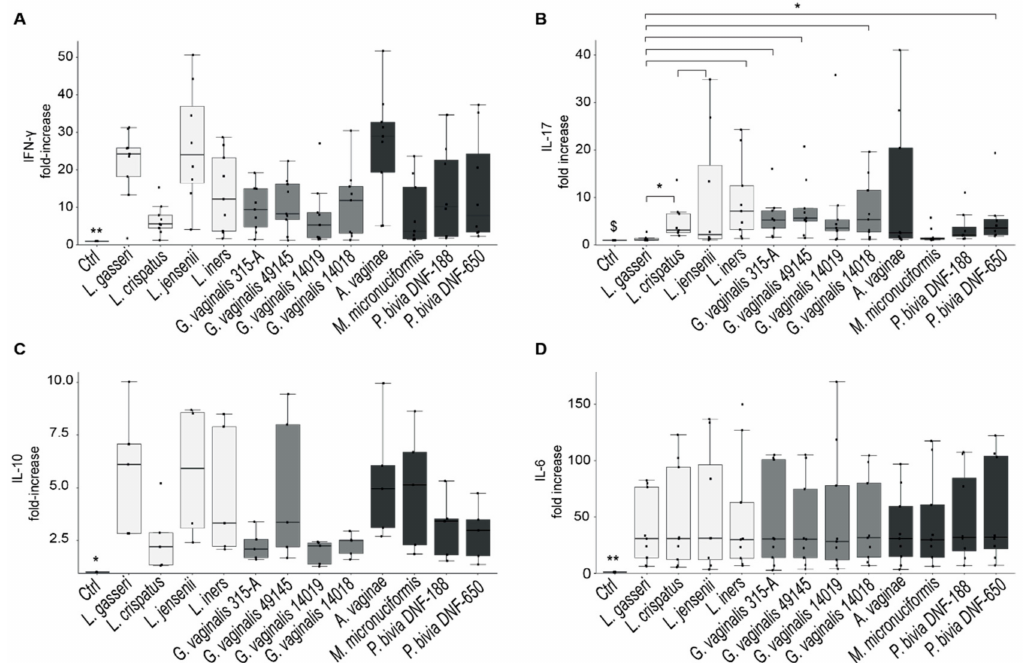
Figure 3. Cytokine’s production by PBMCs stimulated with dominant species of the vaginal microbiota. PBMCs were stimulated with 50 MOI/cell of heat-inactivated bacteria for 5 days. ( A ) IFN- γ , ( B ) IL-17, ( C ) IL-10 and ( D ) IL-6 concentration was measured in culture supernatants of bacterial-stimulated cultures. Results are expressed as a fold increase in cytokine concentration with respect to unstimulated cultures. The bar graph shows the median, and the whisker is calculated on the formula IQR × 1.5. Differences in cytokine concentrations among cultures were evaluated by Kruskal–Wallis test with Holm–Bonferroni p-value adjustment. $ p -value referred to unstimulated cultures; * p < 0.05; ** p <